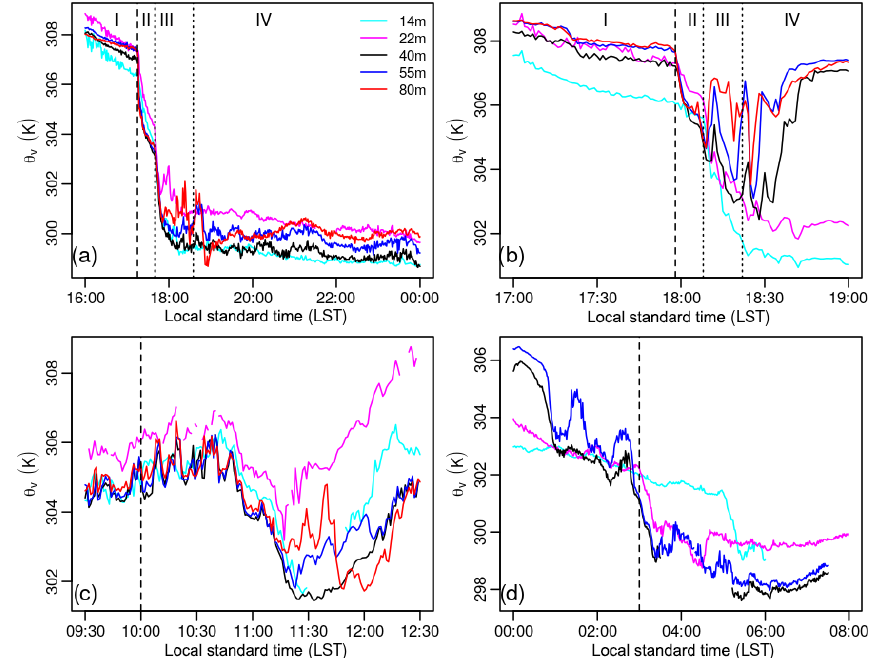
Figure 3. The same as in Fig. 2 but for virtual potential